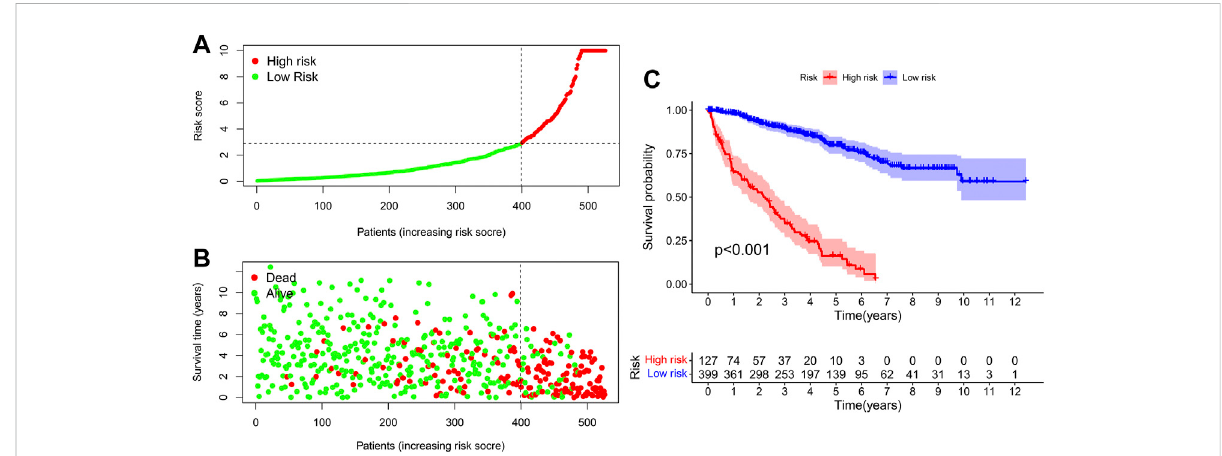
FIGURE 4 The signature for prognosis prediction in ccRCC. (A) Risk score curves in ccRCC patients. (B) Distribution of living conditions in patients with ccRCC. (C) Kaplan-Meier whole living pro fi les of high-risk as well as low-risk groups in prognostic signature.